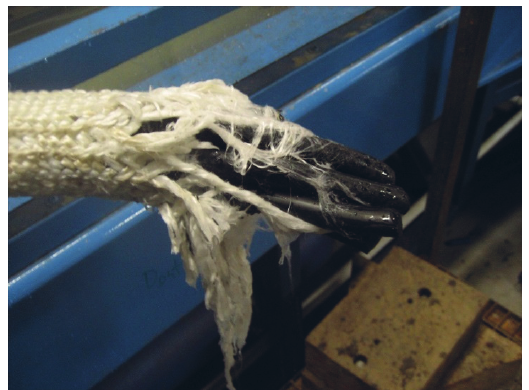
Figure 13. Failed tether under fatigue cycle